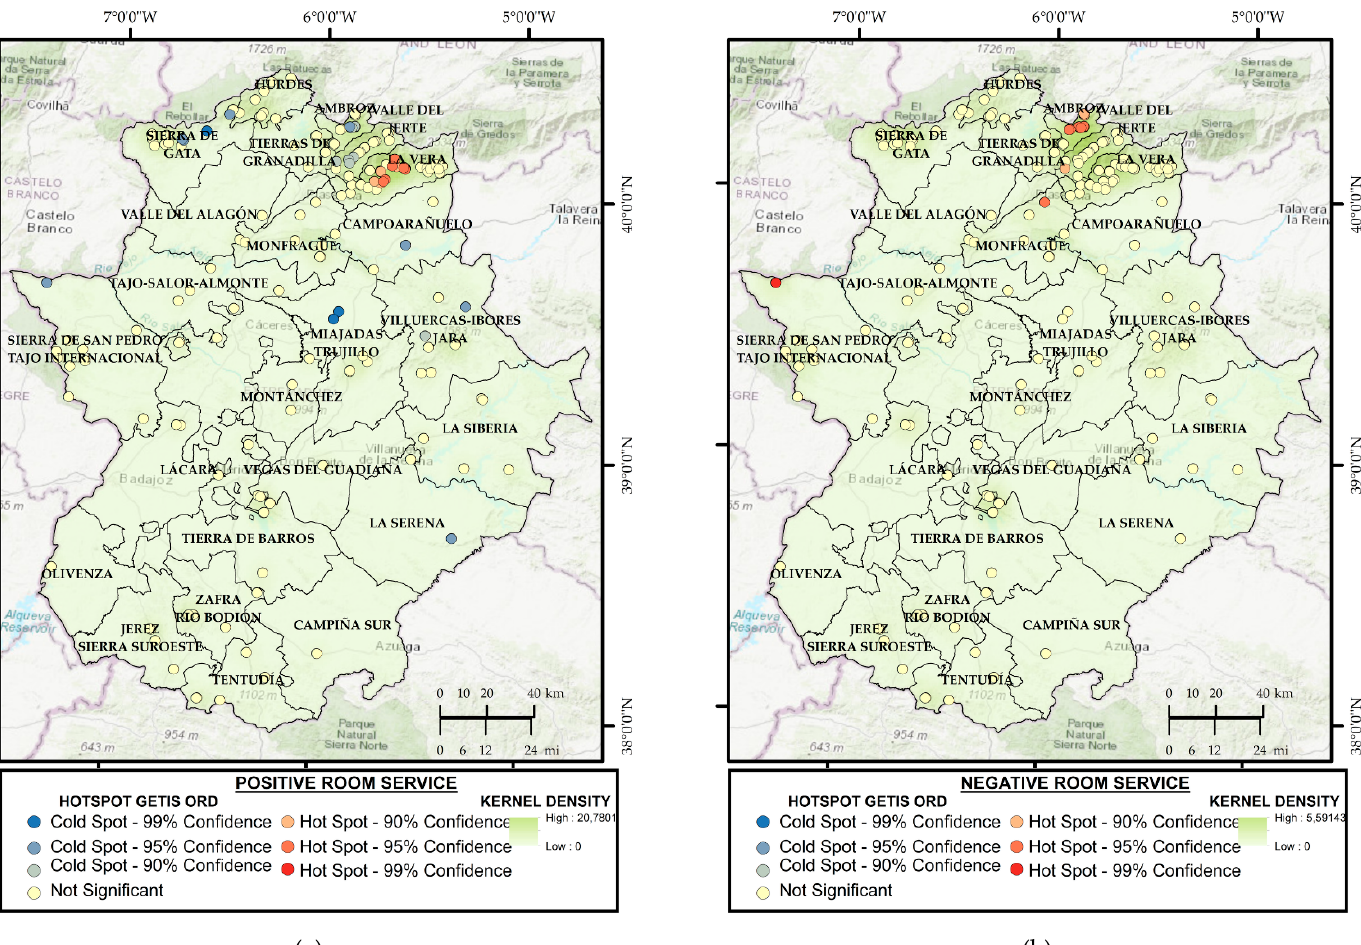
Figure 11 . Gi* Getis Ord Room Service Positive ( a ) and Negative ( b ) mentions Figure 11. Gi* Getis Ord Room Service Positive ( a ) and Negative ( b )